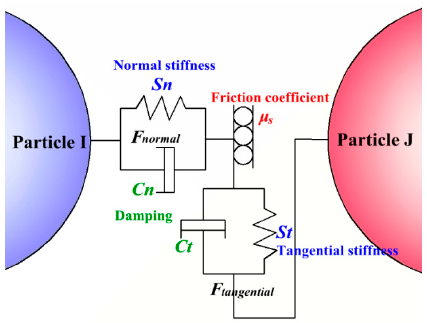
Figure 1. Graphic representation of the linear-spring/dashpot soft-sphere model.